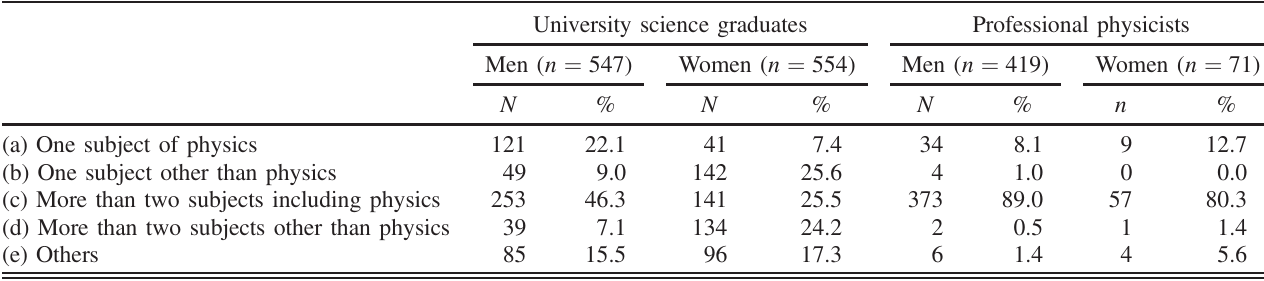
TABLE III. Five patterns of the choice of science subjects for university entrance